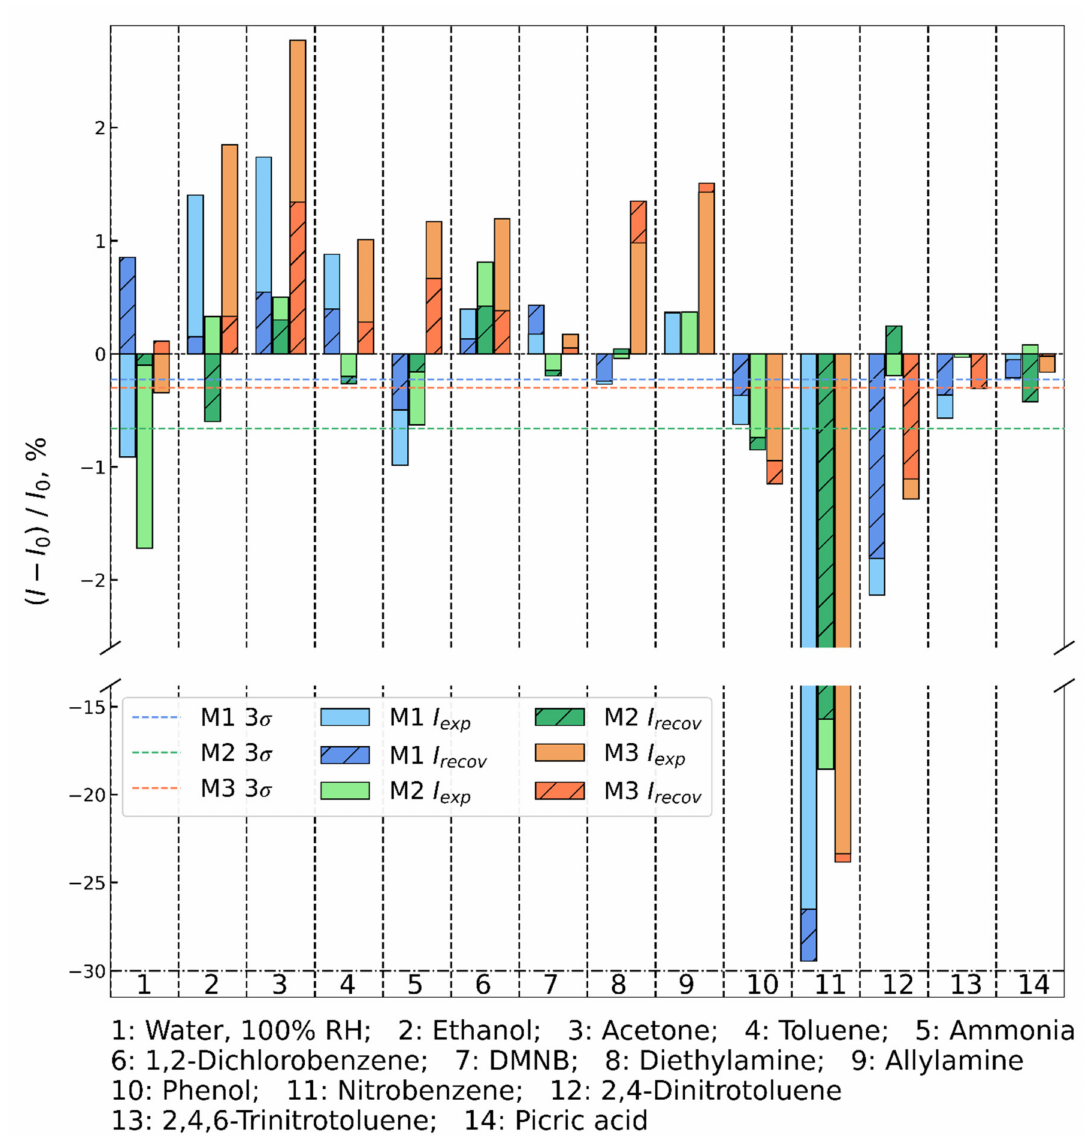
Figure 13. Fluorescence responses of sensor materials M1 – M3 towards saturated vapors of inter- ferents and nitroaromatic compounds in a 50 s exposure interval. The 3 σ noise levels of registered fluorescence intensity differences are marked with horizontal dashed